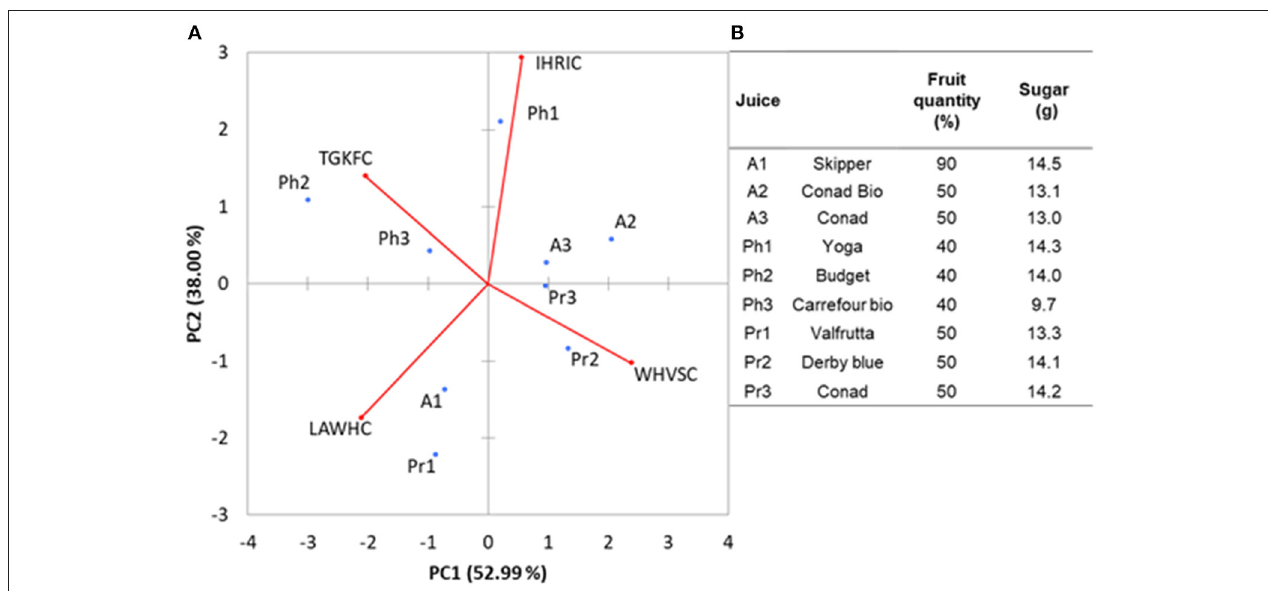
Frontiers in Chemistry |